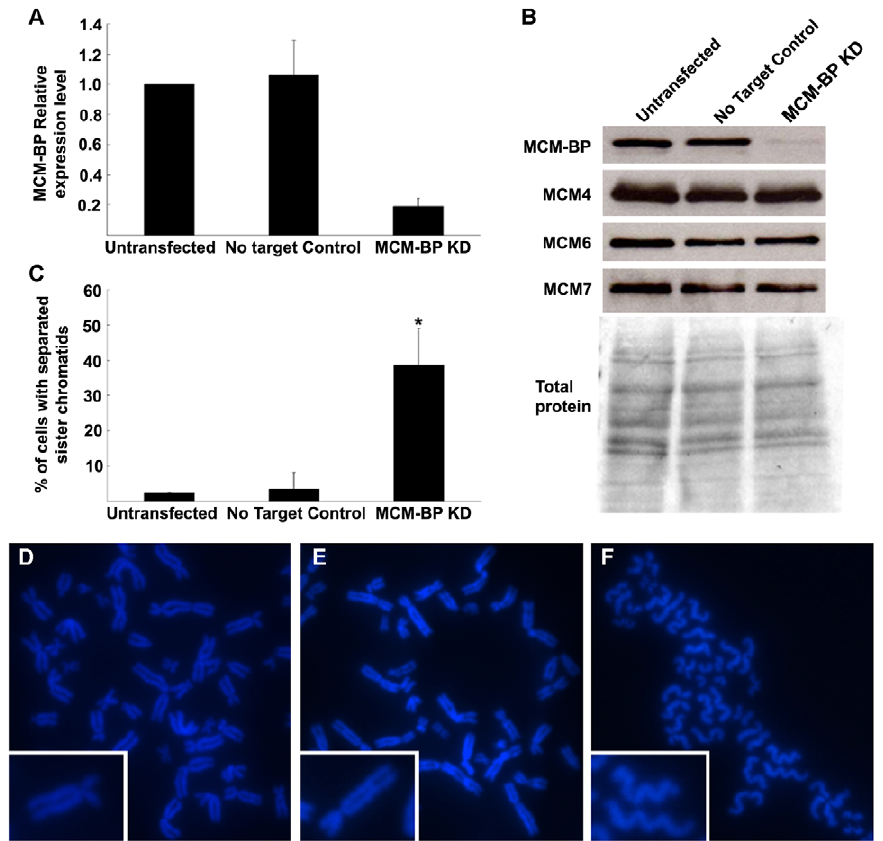
Figure 7. Induction of cohesion defects by downregulation of human MCM-BP . (A) MCM-BP transcript levels in siRNA transfected HEK-293T cells versus untransfected and transfected control cells. Samples were harvested 48 h after transfection. All values were normalized against the expression level of the TBP and UBC genes. (B) MCM-BP, MCM4, MCM6, and MCM7 protein levels in samples as described in (A). (C) Quantification of nuclei showing totally separated sister chromatids (n . 100 per condition, obtained from two independent transfection experiments). The asterisk marks a significant difference by Student’s t -test (P-value , 0.05). (C–E) Representative images of mitotic spread of untransformed (D), control transfected (E), and MCM-BP siRNA-transfected HEK-293T cells (F). Insets show higher magnification images of single sister chromatid